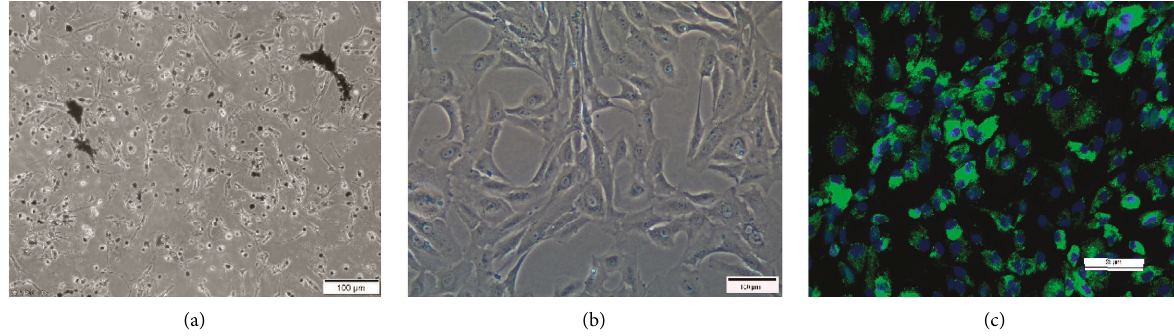
Figure 1: (a) Primary human RPE cells showing high levels of confluence and pigmentation after 24 (h). (b) Third-generation RPE cells are spindle-shaped, triangular, or irregular in shape, with a reduced number of cytoplasmic pigment granules. (c) Third-generation RPE cells fixed in 4% paraformaldehyde and incubated with an anti-RPE65 antibody. DAPI (blue) was also added to stain the